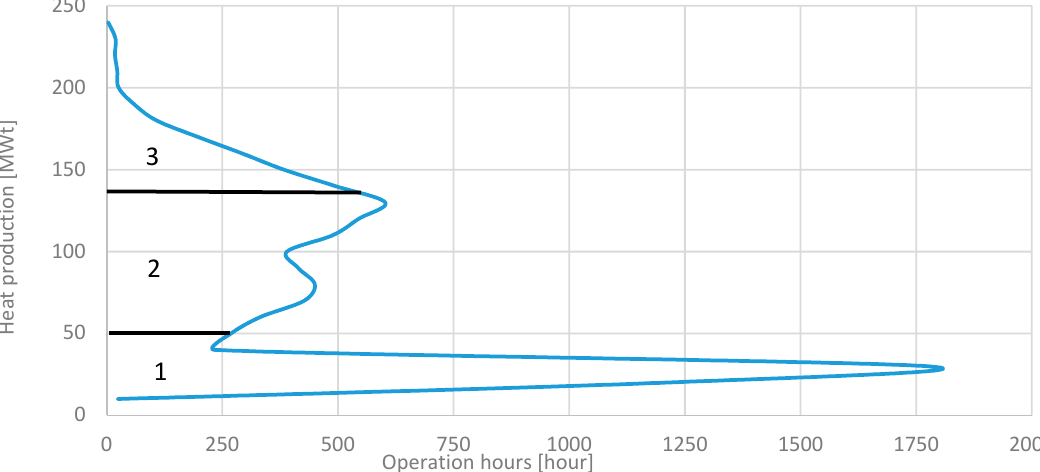
Figure 3. Limitation of the BPT at the produced heat power by the CPP in 2016 [5].